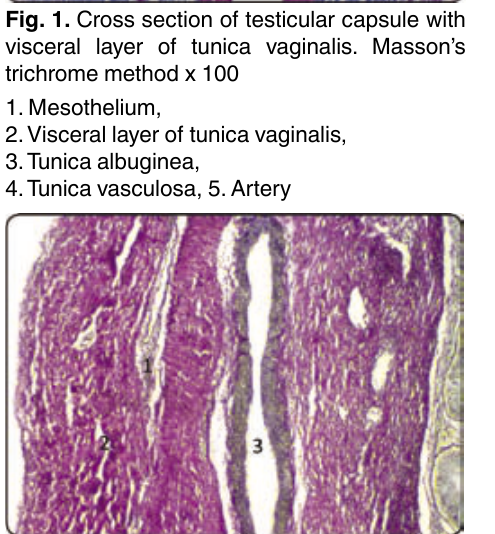
Fig. 4. Cross section of testicular capsule with visceral layer of tunica vaginalis. PTAH method for muscles x 100